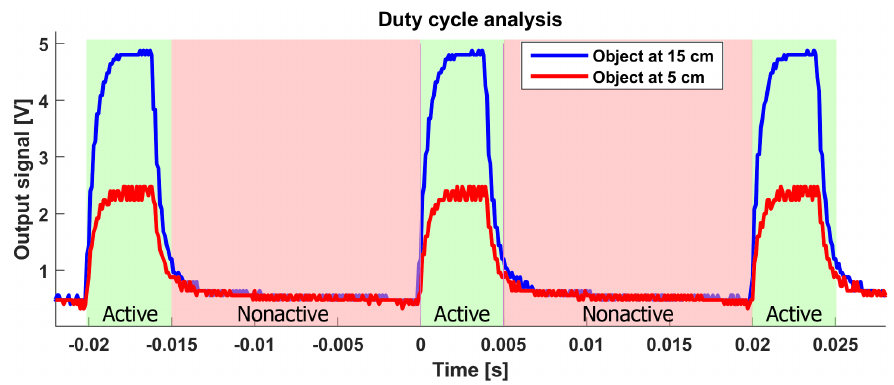
Figure 10. Oscillogram of analog sensor output at 50 Hz and 20% duty